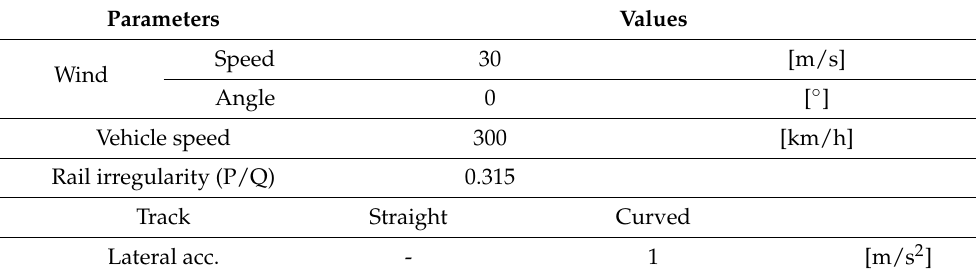
Table 15. The symbols used in the damped vibration equation. Parameters